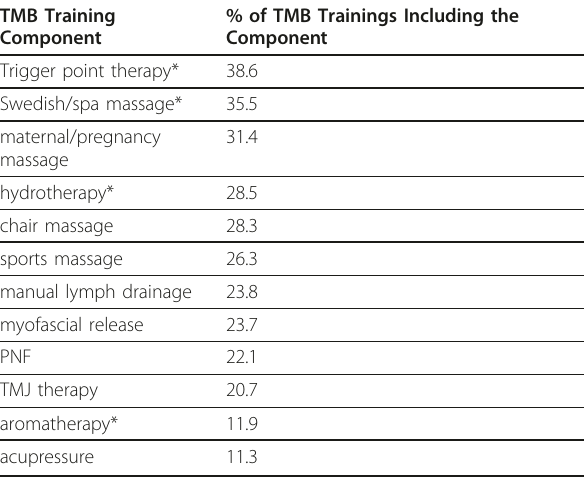
Table 4 Additional TMB components included in